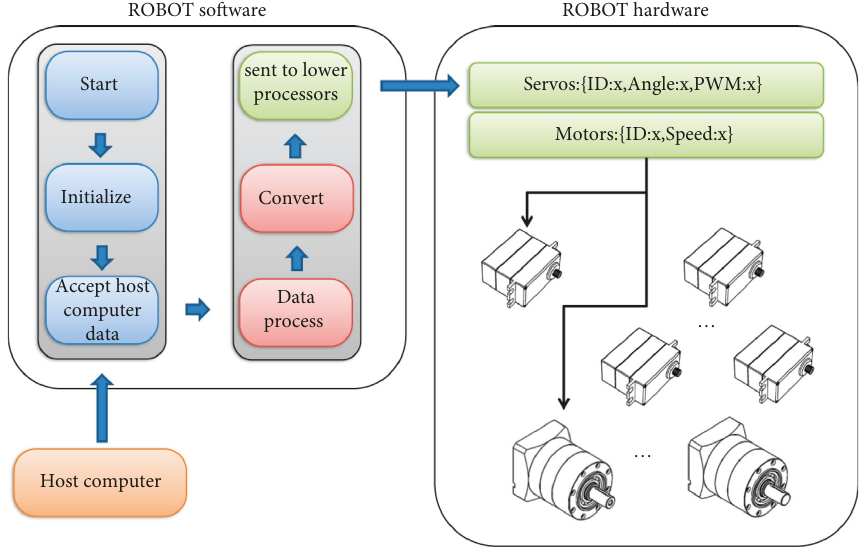
Figure 1: Principle of robot operation.